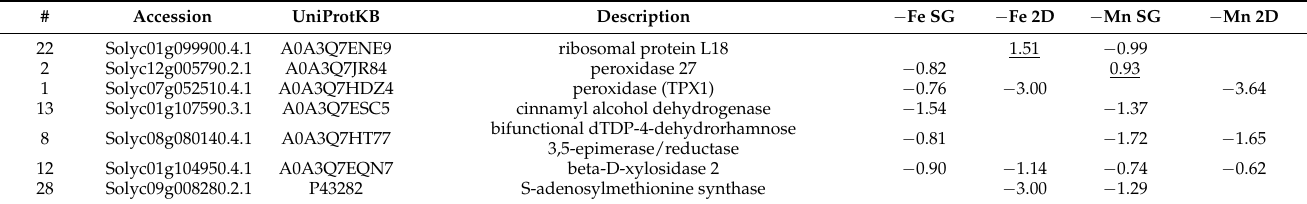
Table 4. Identified and quantified proteins (7 in total) affected by both Fe and Mn deficiencies. Accession code is from the ITAG 4.0 database. Fold changes correspond to the base 2 logarithm of the fold change between the corresponding deficient sample to the control samples.